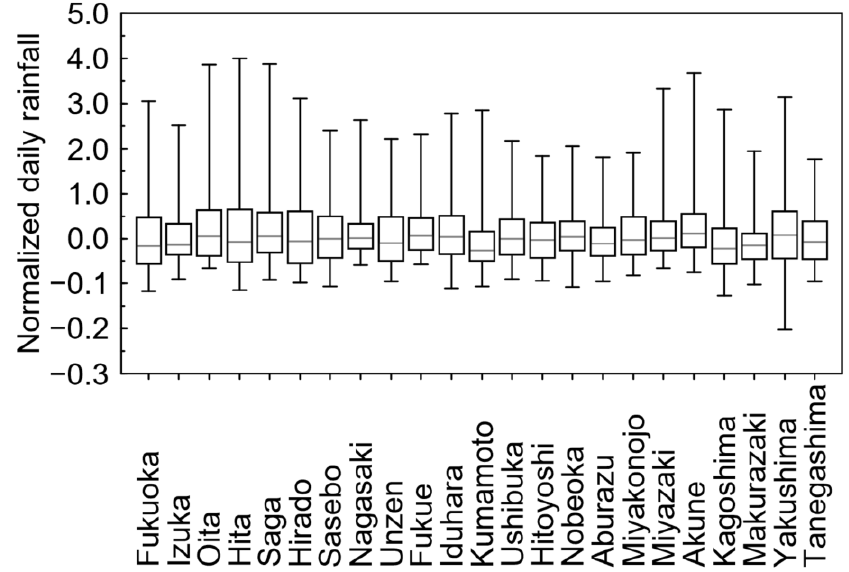
Figure 5. Boxplots for normalized values of annual maximum daily rainfall at 23 stations. Whiskers of the box show 25th (lower) and 75th (upper) percentile values. The gray line is the median value.